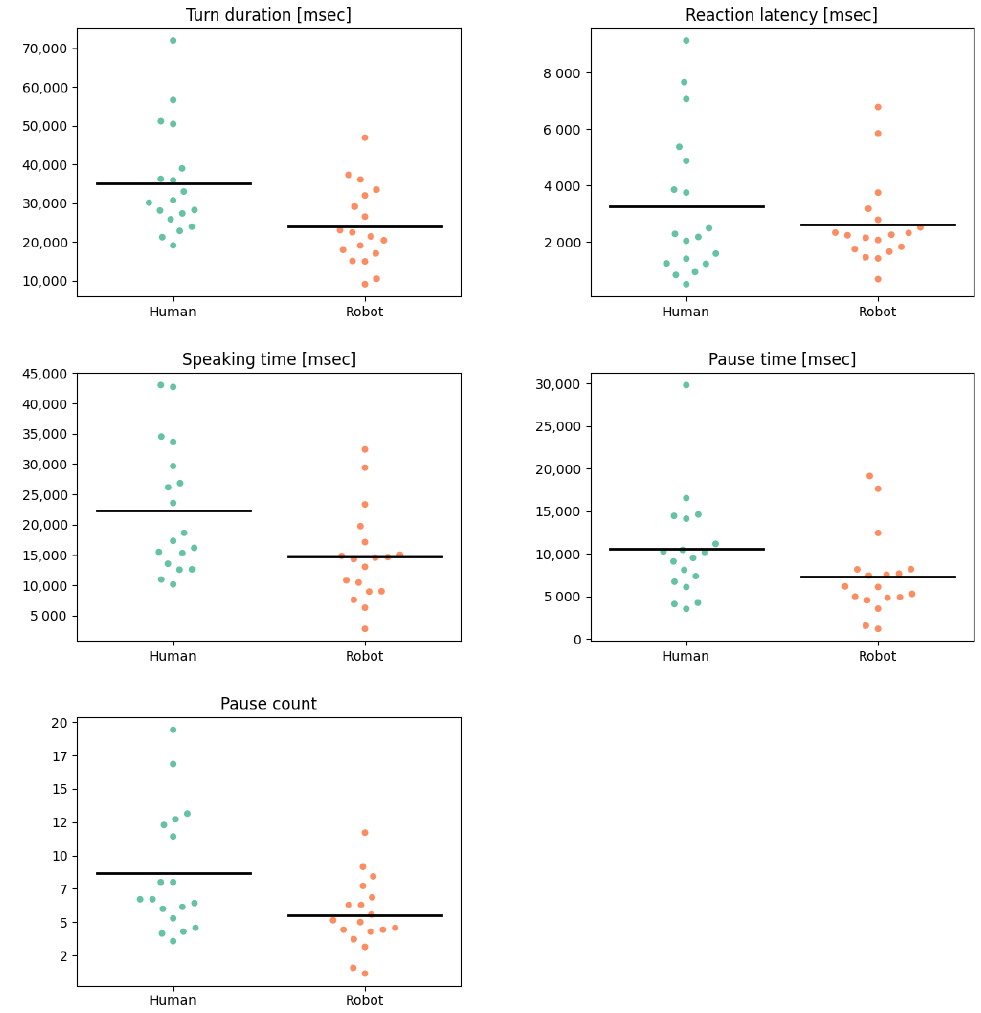
Figure 6. The raw data of measurements of non-verbal behavior in each participant’s